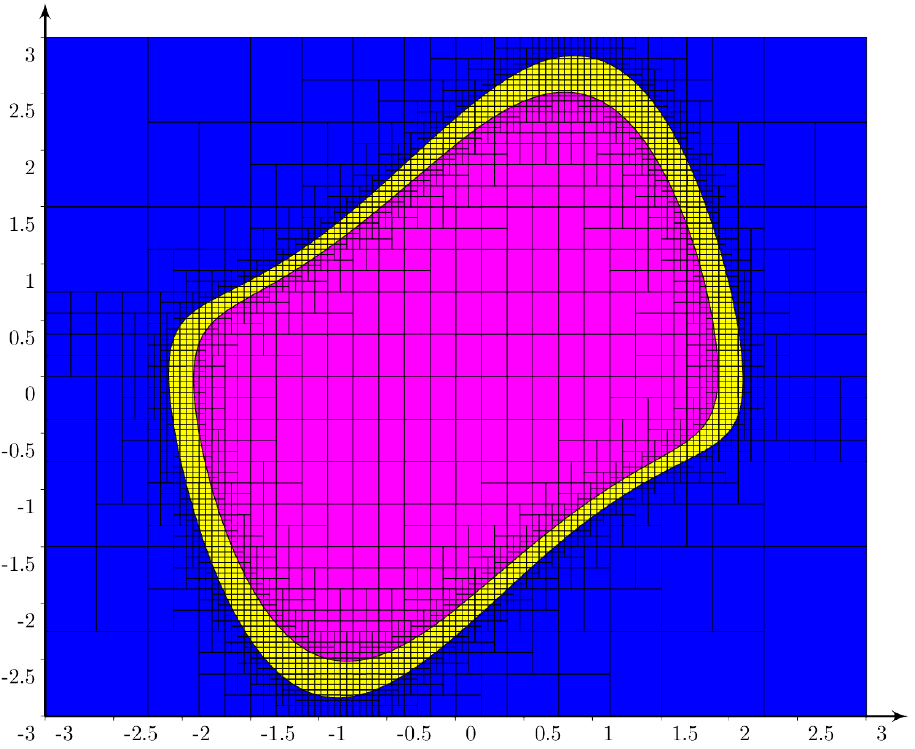
Figure 8. Approximation of the greatest negative invariant set included in the frame box A